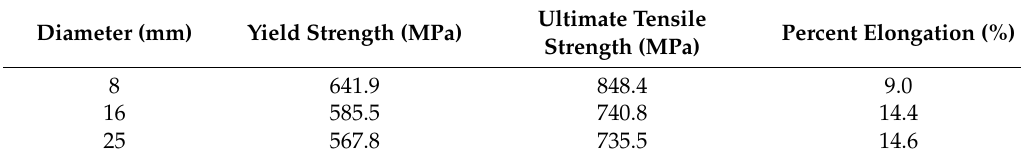
Table 2. Major properties of high-strength reinforcement.